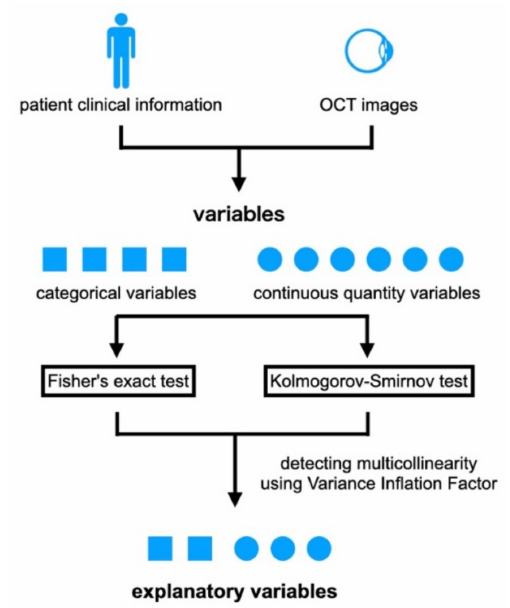
Figure 2. Fisher’s probability of correct answer test was conducted for categorical variables for vari- ables extracted from clinical information and OCT images. K–S tests were conducted for continuous quantity variables. Variables that had a statistically significant difference between Groups A and B were used as candidates for explanatory variables. Among these variables, those with variance inflation factor values greater than 10, that is, those with R 2 scores greater than 0.9, were eliminated. One variable with the highest R 2 score greater than 0.9 was eliminated, and the tests were conducted until the R 2 score for all variables was less than 0.9. Lastly, the remaining variables were used as the explanatory